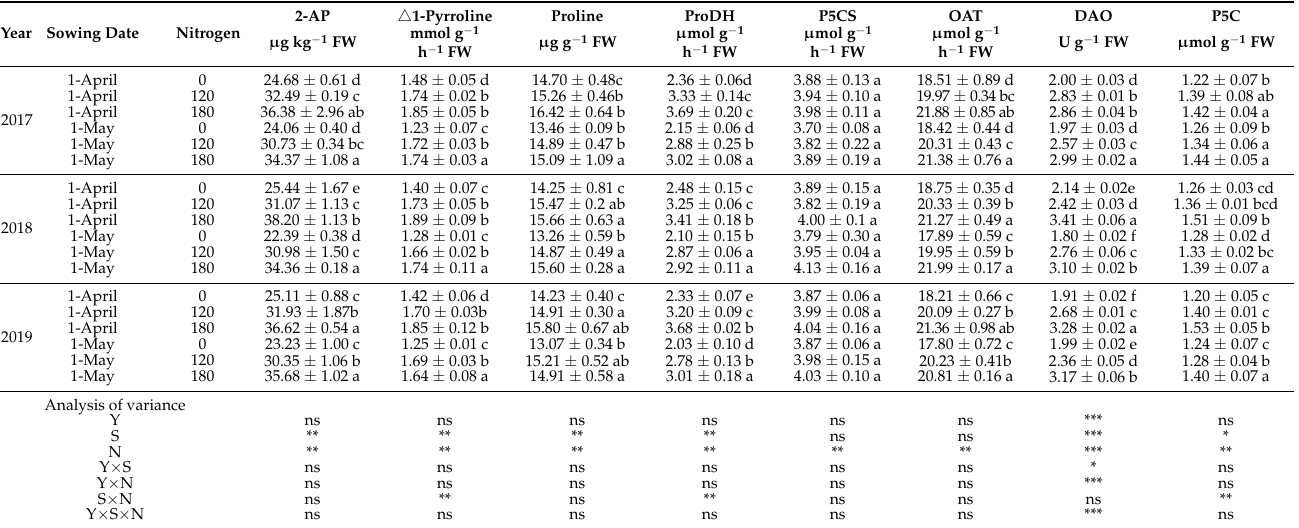
Table 5. Effect of sowing date and nitrogen application on 2-AP, synthetic precursors and enzymes involved in 2-AP biosynthesis in